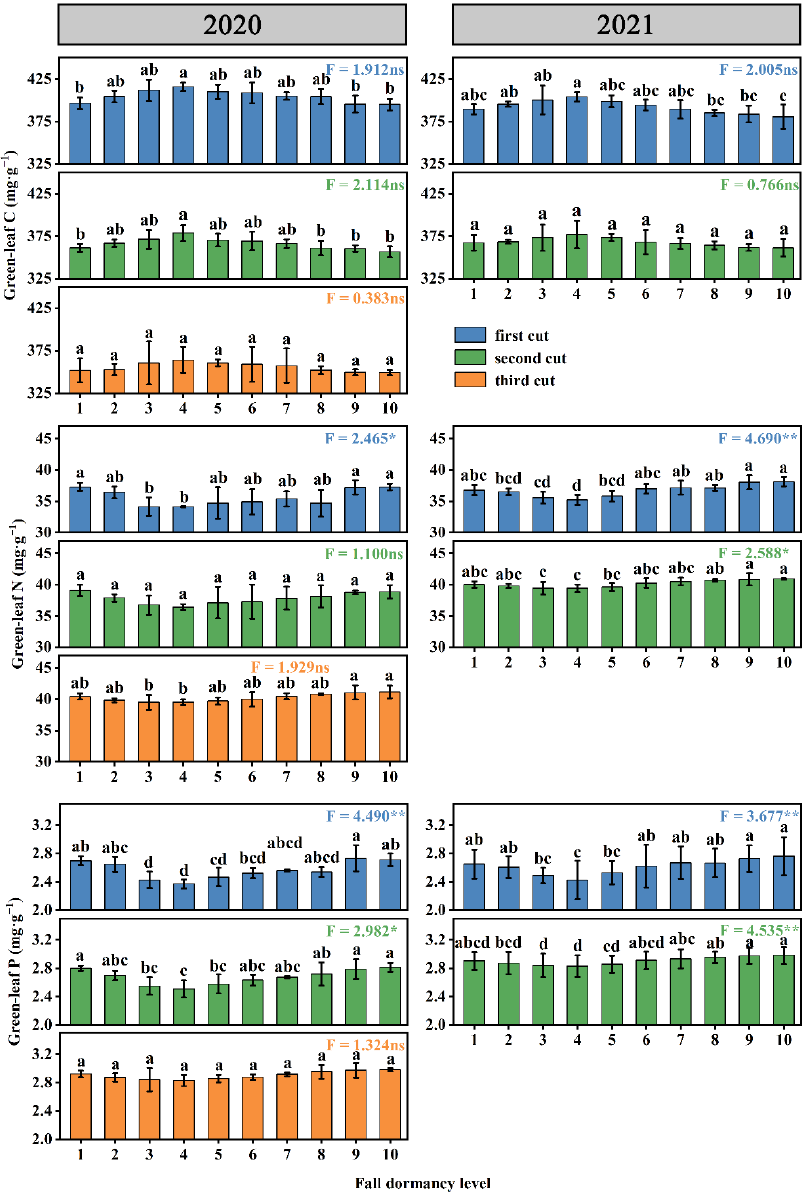
Figure 2. Stoichiometric characteristics of mature alfalfa leaves with different fall-dormancy levels (2020–2021). Different small letters indicate significant differences between different fall dormancy levels ( p < 0.05). ns indicates no significant difference between different fall dormancy levels ( p > 0.05), * indicates significant difference between different fall dormancy levels ( p < 0.05) and ** indicates extremely significant difference between different fall dormancy levels ( p < 0.01).